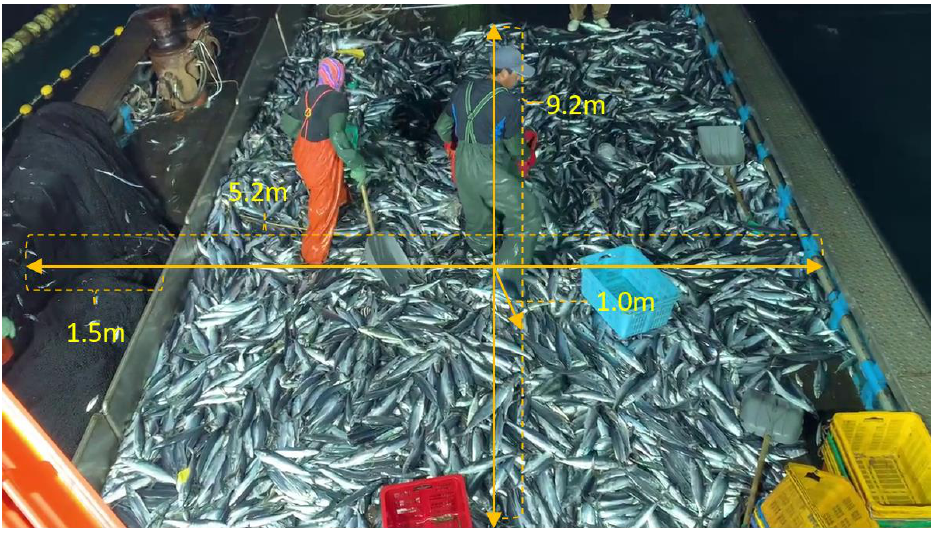
Figure 10. Representation for the size of the place where the caught fish are located.